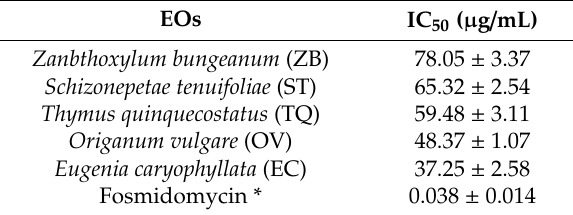
Table 1. IC 50 values of the EOs of ZB, ST, TQ, OV, and EC against